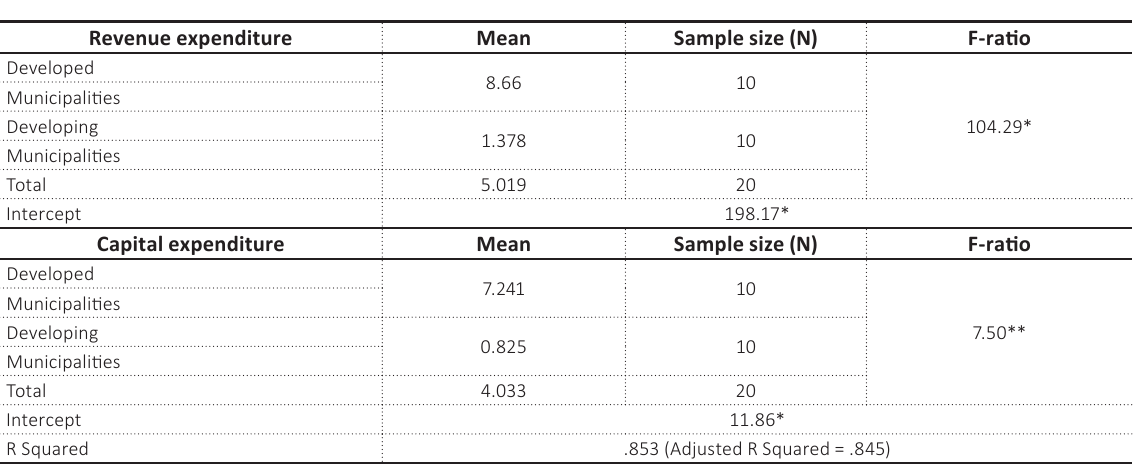
Table 6. Revenue and capital expenditure of developed and developing